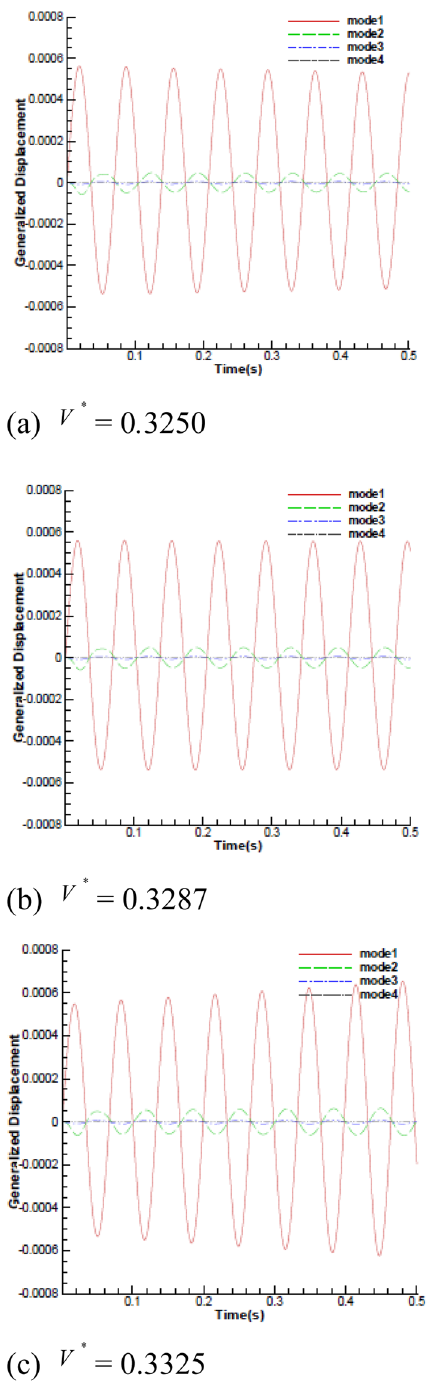
Figure 3. Time histories of generalized displacements at Ma = 0.96 with different reduced